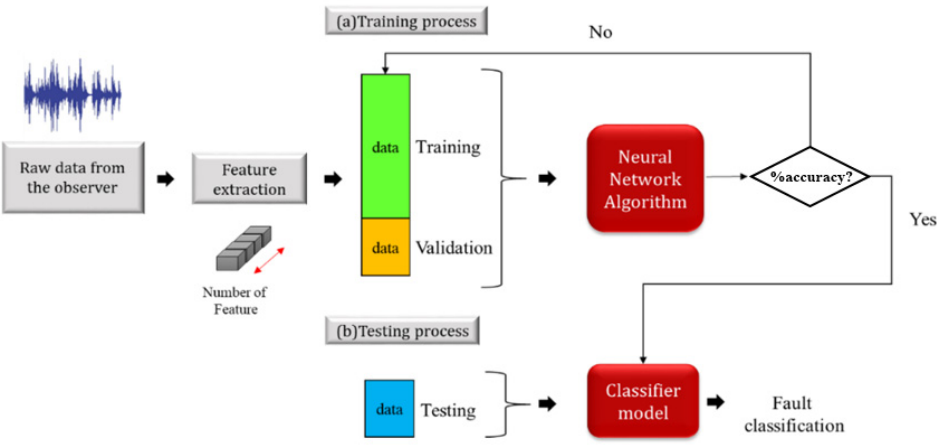
Figure 8. The procedure flow of the classification model.